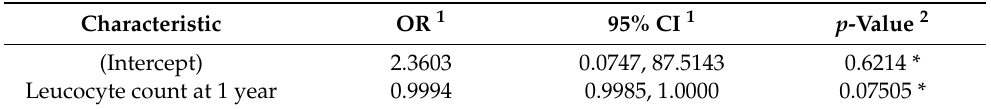
Table A4. The summary of the model hepatocellular carcinoma (HCC) vs. leucocyte count at 1 year, presented in Figure 5. Logistic model for rare events (Firth method, penalized method).